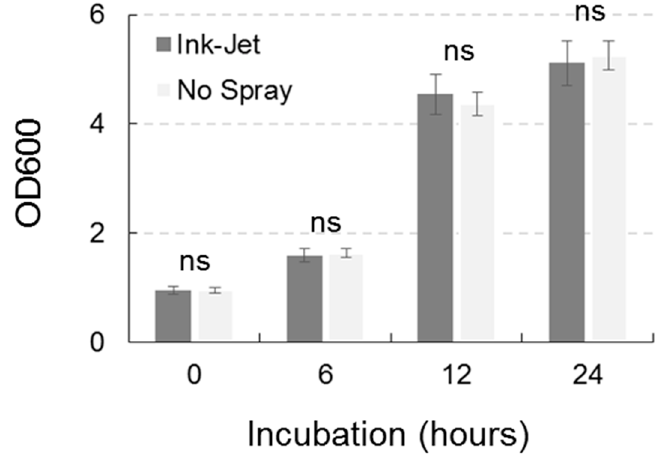
Figure 6. Growth of Bacillus subtilis in relation to treatment with ink-jet spray system. Data are means ± standard deviation, ns = statistically insignificant difference (Duncan’s test).